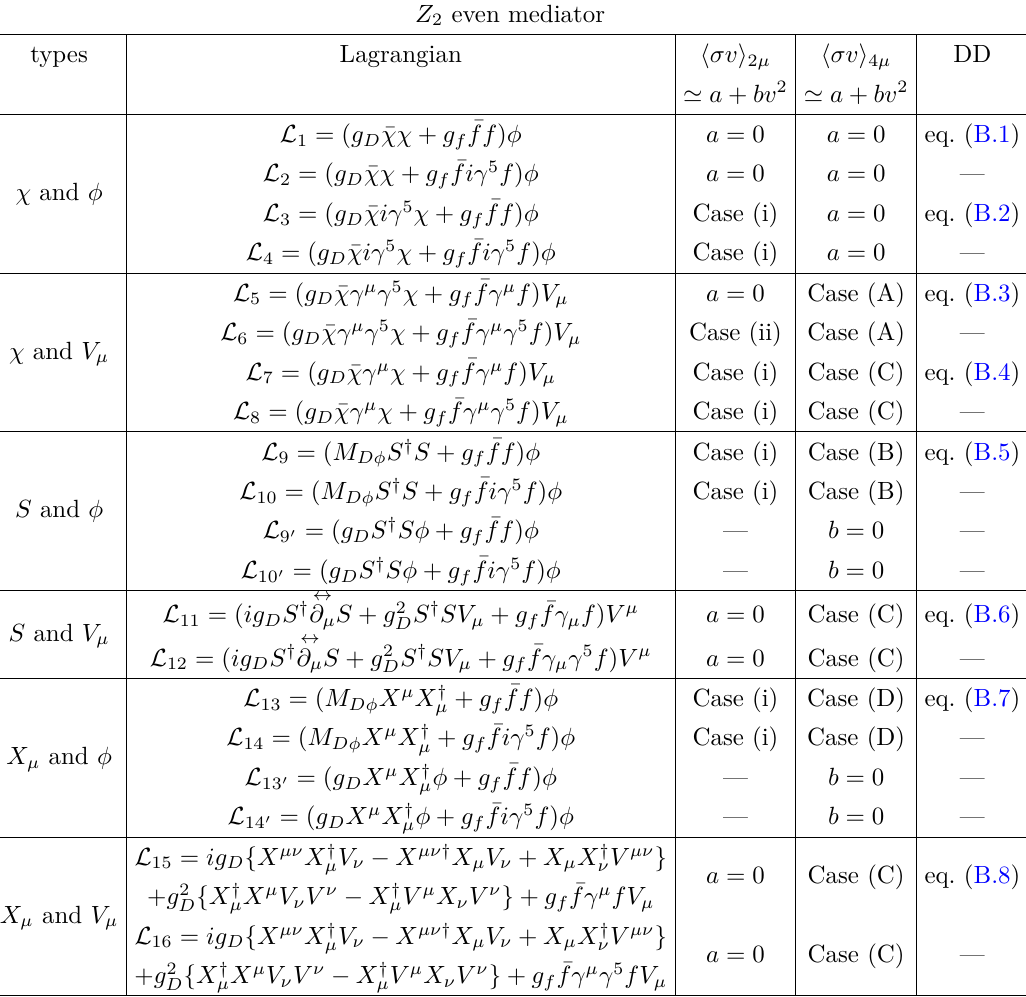
Table 2 . The summary table of all the renormalizable operators for the Z 2 even mediator scenario. The columns h σv i and h σv i show the cross sections of DM annihilation to 2 µ and 4 µ 2 µ 4 µ